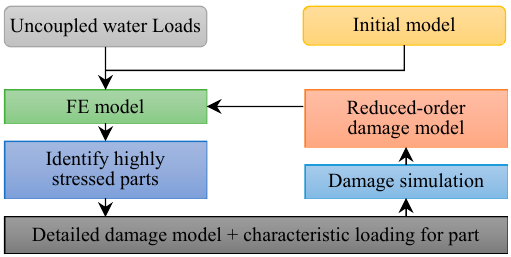
Figure 12. The iterative process of model creation .